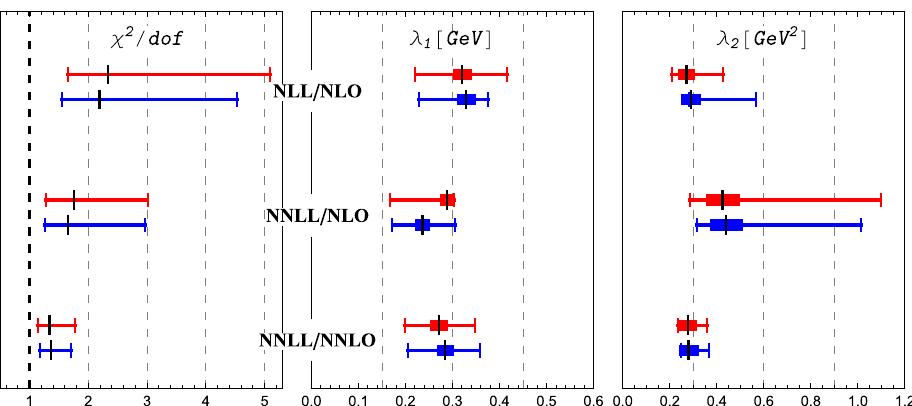
Fig. 8 The values of parameters for f NP extracted from the global fit with g K = 0. Red marks represent the extraction with model 1. Blue marks represent the extraction with model 2. The black marks show the valuesofparametersextractedat c 1 , 2 , 3 , 4 = 1.Thethickbandsrepresent